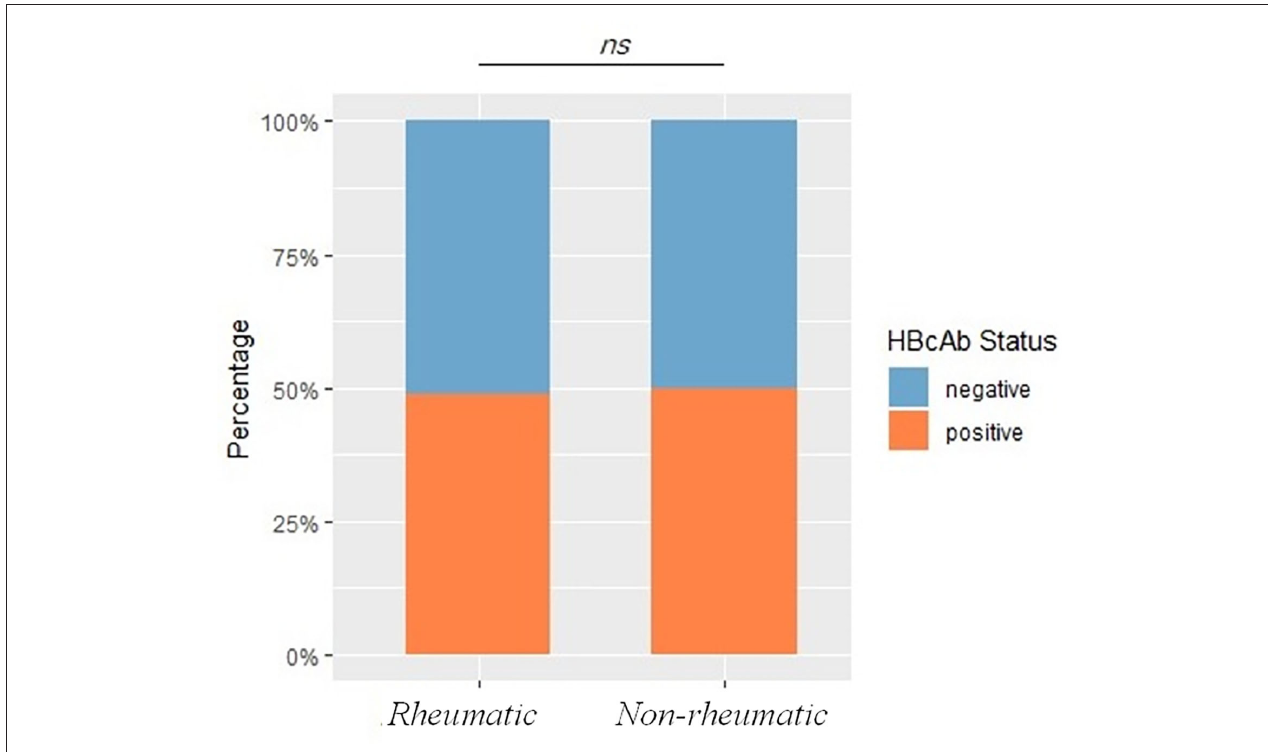
FIGURE 2 | Exposure rates between rheumatic and non-rheumatic patients and demographics before propensity score matching (PSM). The bar plot shows HBV exposure rates, represented by HBcAb status, between rheumatic and non-rheumatic patients. A p < 0.05 was considered as statistically significant. Ns stood for